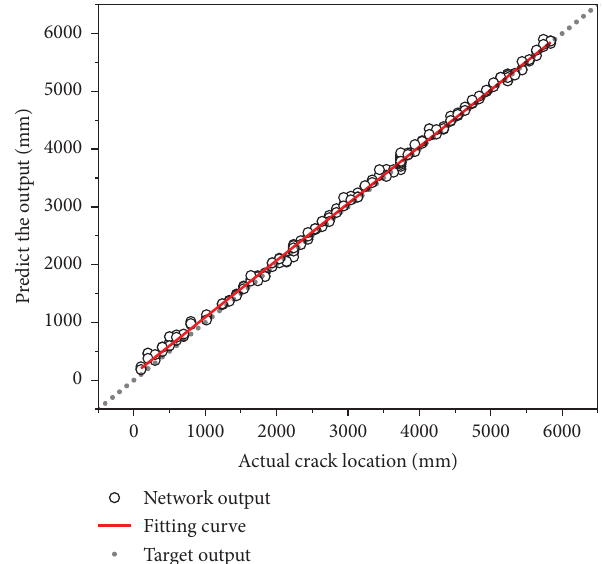
Figure 19: Comparison of the GA-BP neural network model predictions and actual